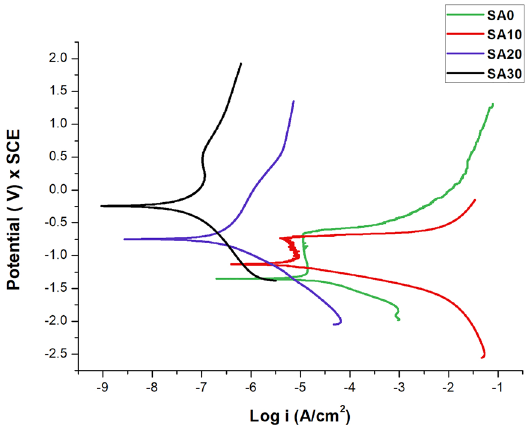
Figure 6. Potentiodynamic polarization curves for aluminum alloy 5052 after treatment in stearic acid and at different etching times in HCl